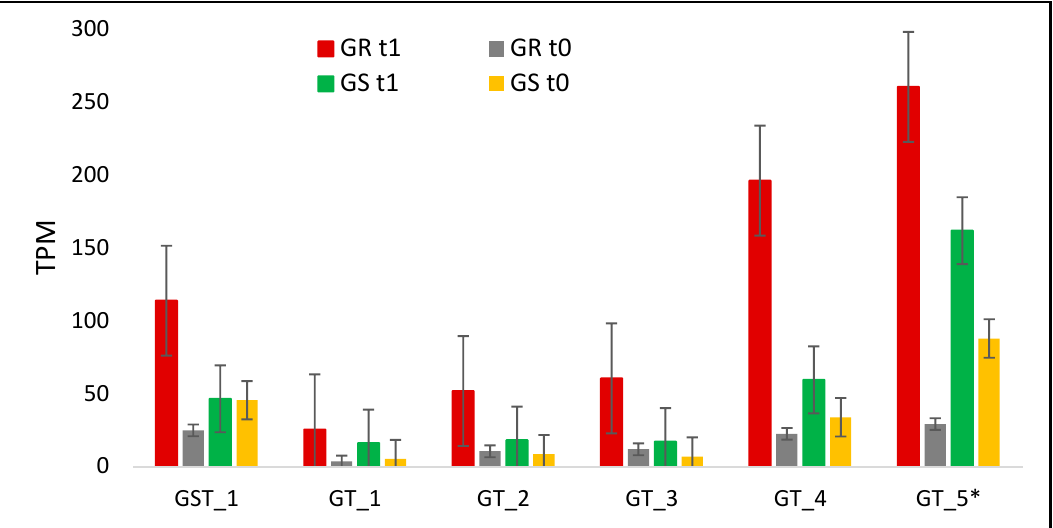
Figure 7. C. bonariensis transcriptome expression analysis (transcript reads per million mapped